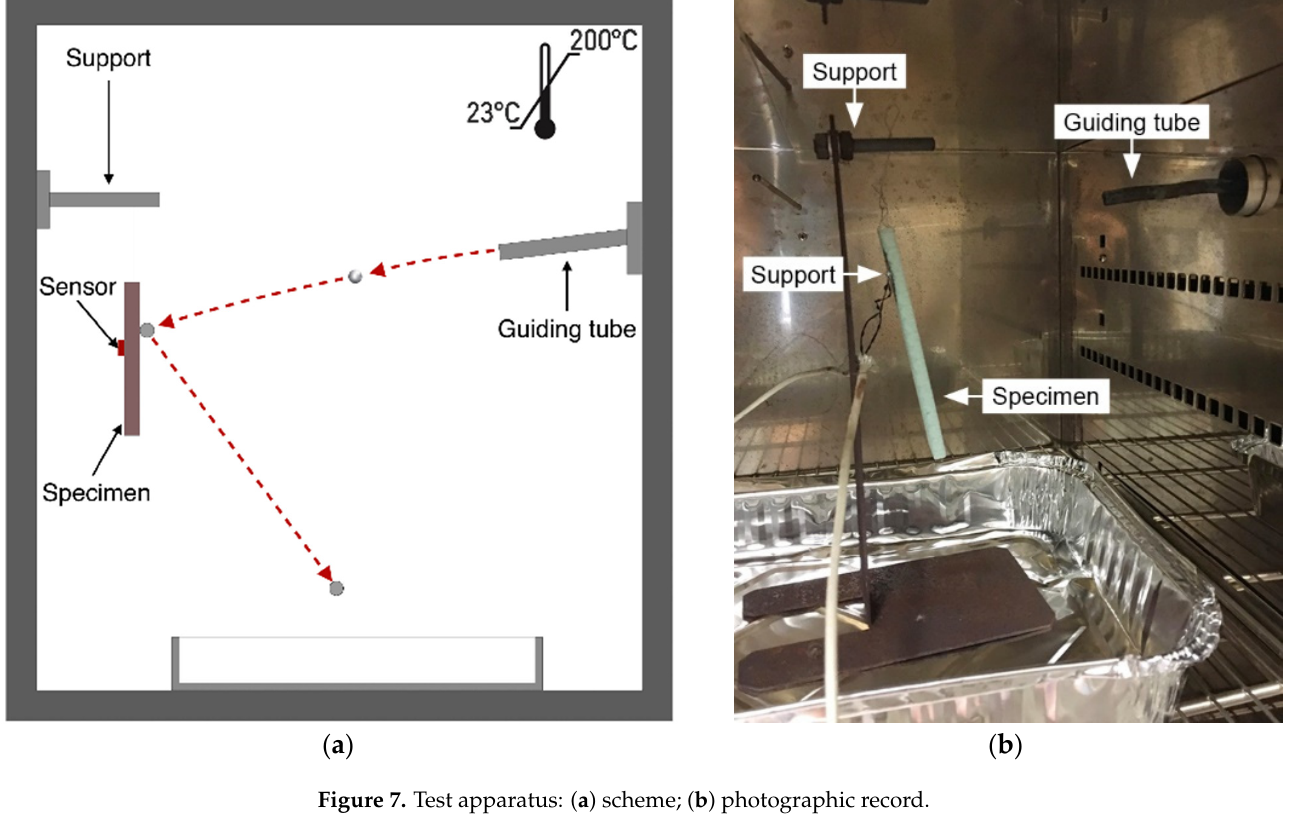
Figure 7. Test apparatus: ( a ) scheme; ( b ) photographic